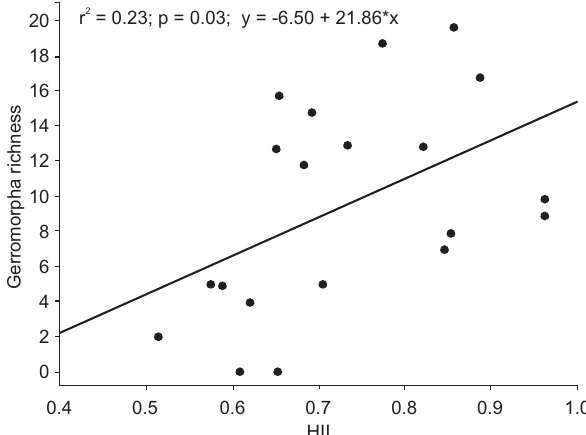
Figure 2. Relationship between the estimated richness of Gerromorpha morphospecies and the Habitat Integrity Index (HII), Pindaíba River Basin, Mato Grosso,